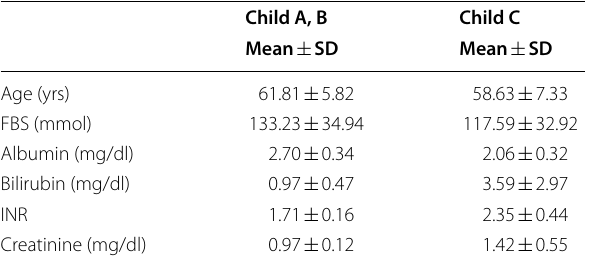
Table 2 Laboratory data of the studied group